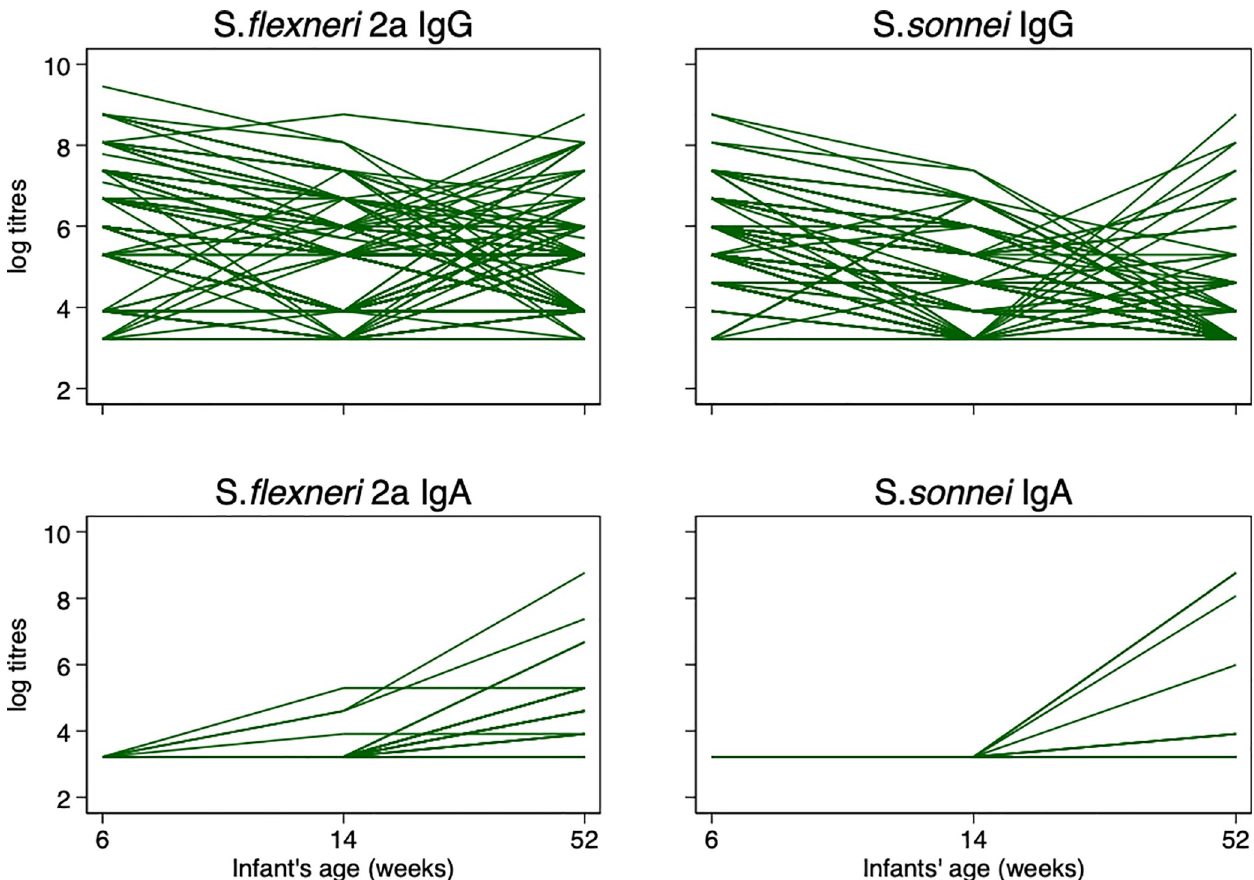
Fig 4. The individual IgG and IgA response profile among infants from 6 to 52